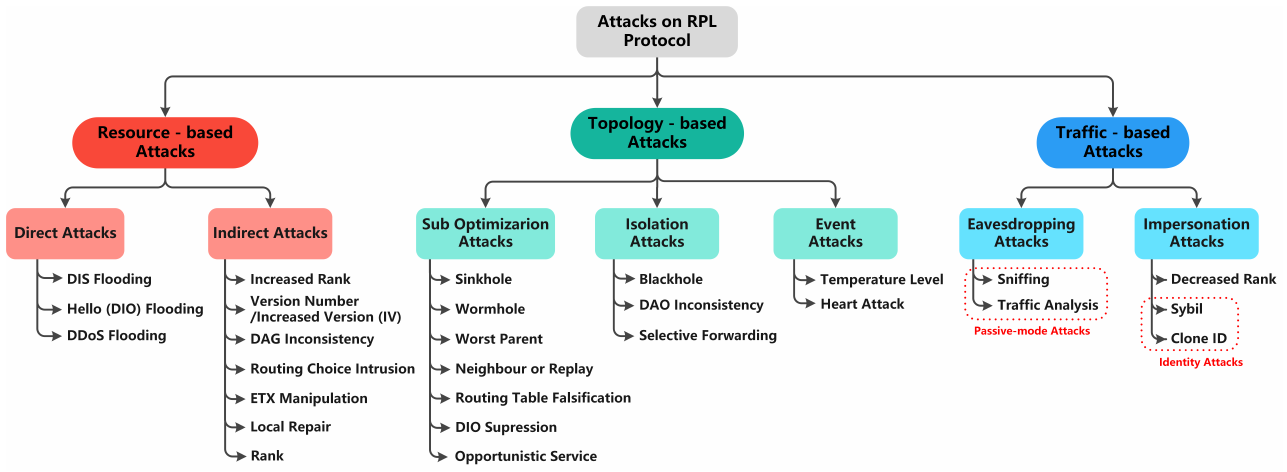
Figure 1. Taxonomy of RPL